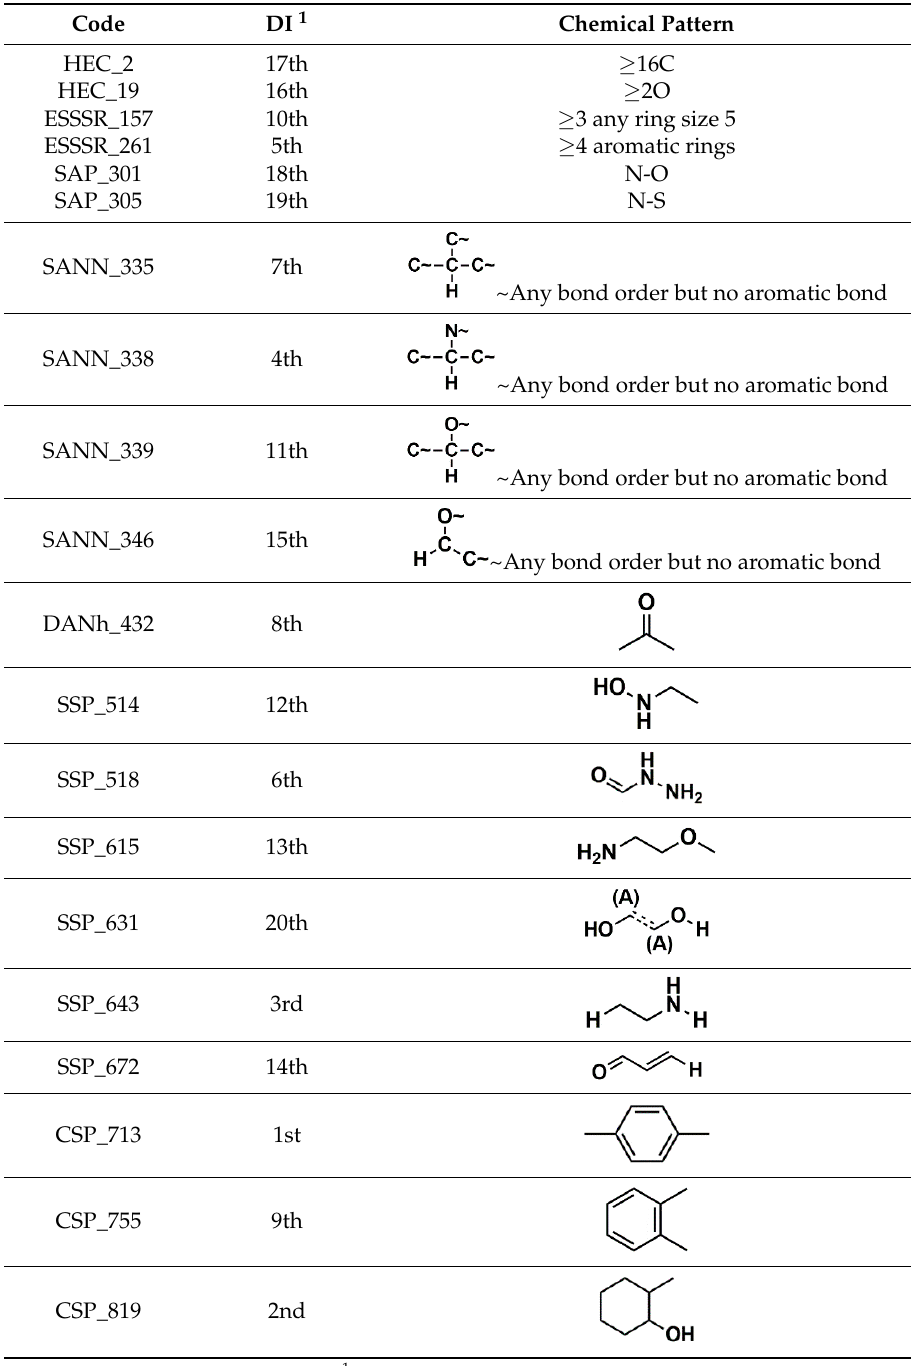
Table 6. Analysis of descriptor importance using to build the best QSAR model for the prediction of the pIC 50 against HCT116.